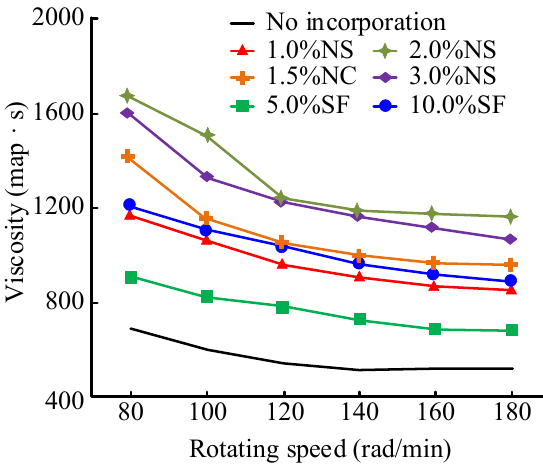
Figure 4. Viscosity analysis of pervious concrete.